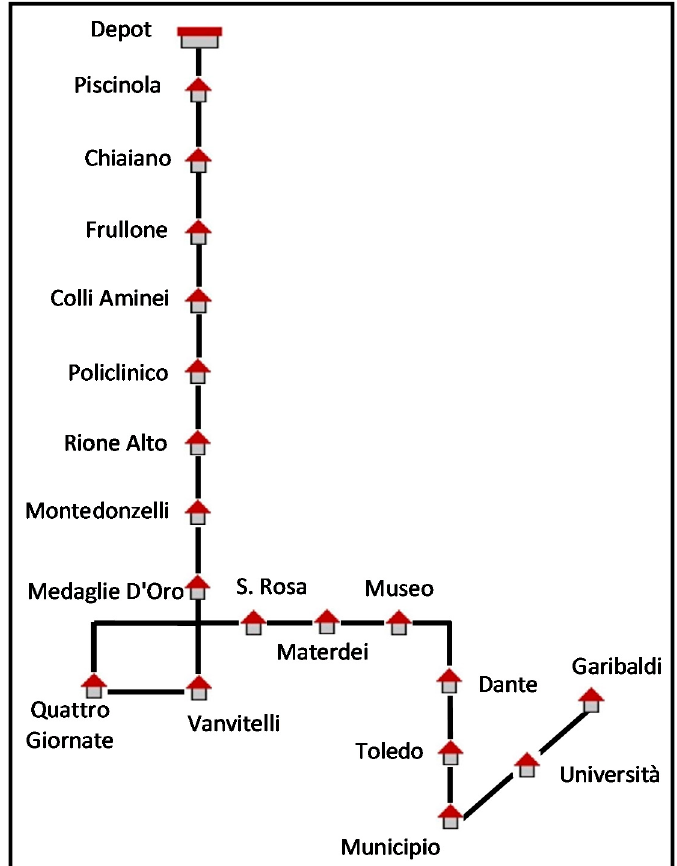
Figure 5. Line 1 of Naples Metro system.